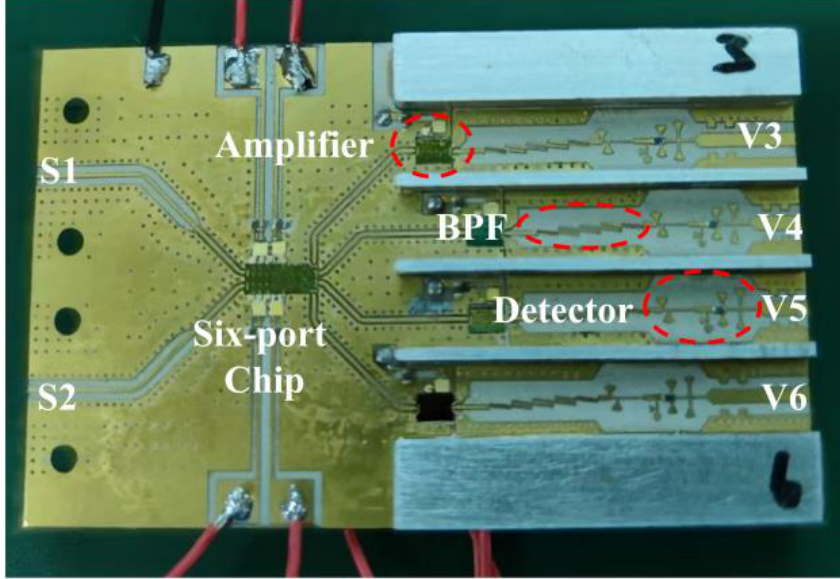
Figure 10. The fabricated analog correlator.